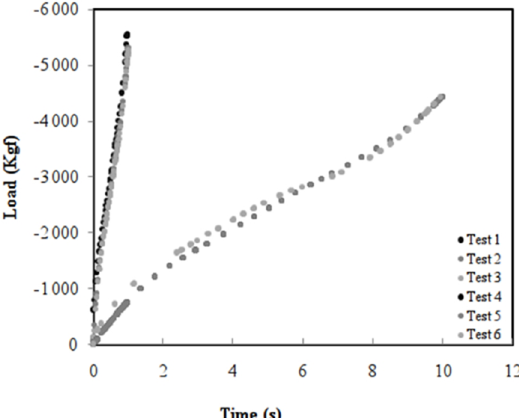
Figure 5. Load vs. Time of the six compression tests carried out to copper at 530+/- 20 °C with two strain rates: 1 and 0.1s -1 Figure 6. Mesh of the control volume in the finite element